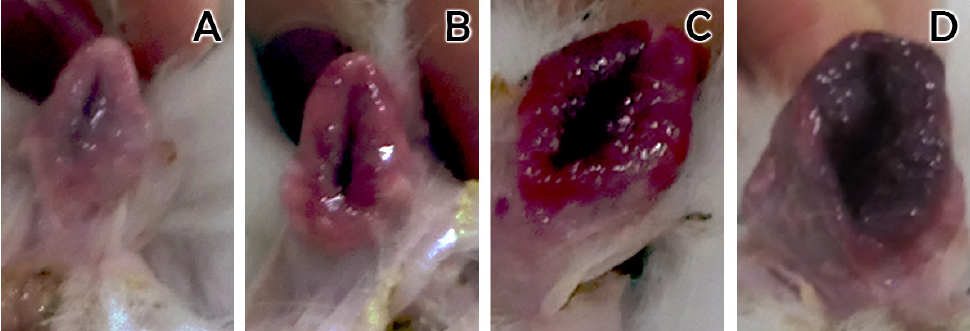
Figure 2. Vulvar color of rabbit doe. ( A ): pale; ( B ): pink; ( C ): red; ( D ): purple.